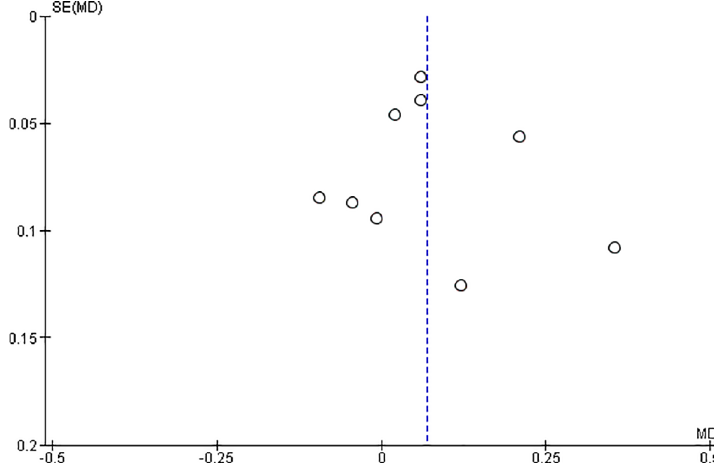
Figure 5. Funnel plot for surface